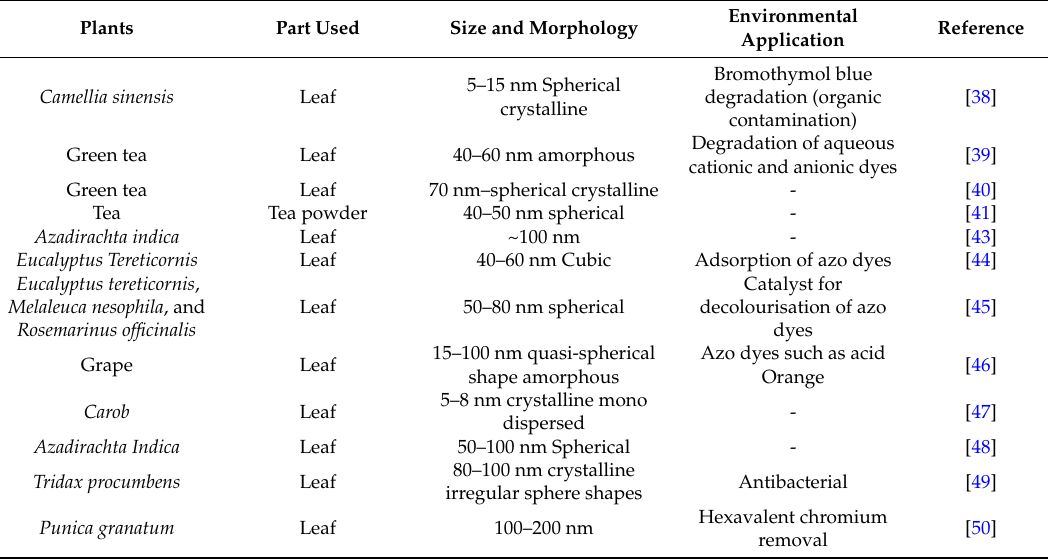
Table 3. Size, morphology and environmental application of Fe 0 /Fe 2 O 3 /Fe 3 O 4 nanoparticles synthesised by different parts of plants and plants